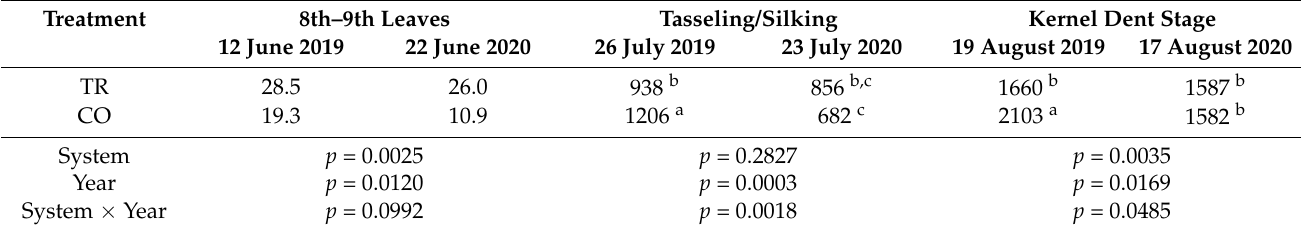
Table 4. Above-ground biomass of maize (g m − 2 ) measured at three different stages of the maize cycle. Different letters are significantly different at p < 0.05 (LSD